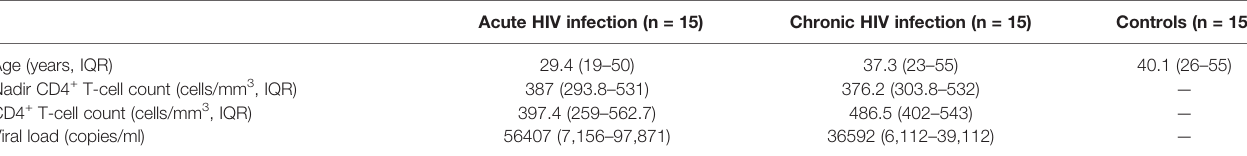
TABLE 1 | Demographic and clinical characteristics of the study